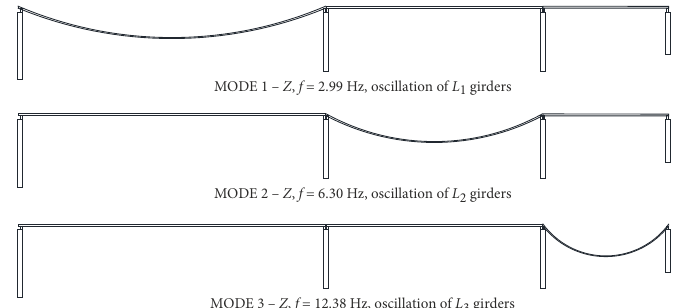
MODE 3 – Z , f = 12.38 Hz, oscillation of L girders Figure 17. Obtained mode shapes in Z direction in the second Ambient Vibration Survey